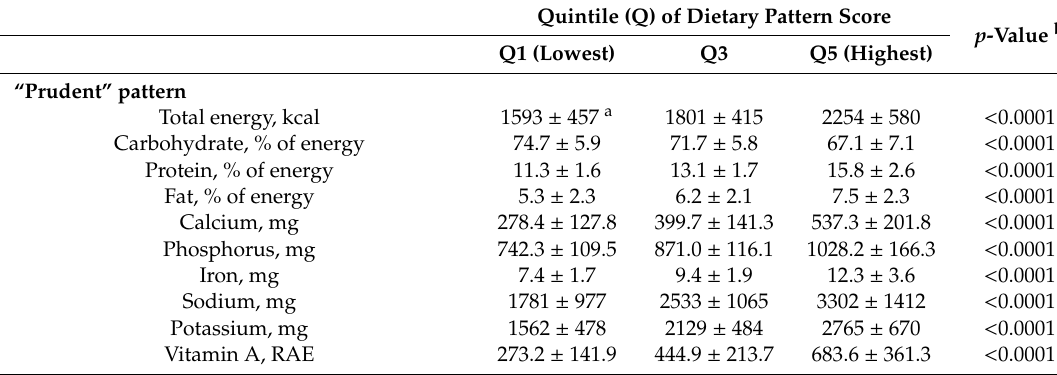
Table 4. Energy and nutrient intake at baseline across quintiles of each dietary pattern score in the middle-aged Korean men, the KoGES-HEXA